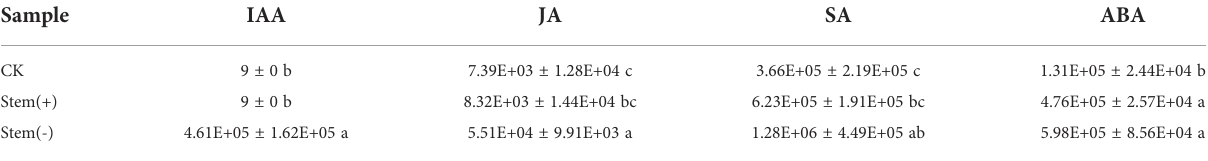
TABLE 2 Phytohormone contents in fl ue-cured tobacco leaves.